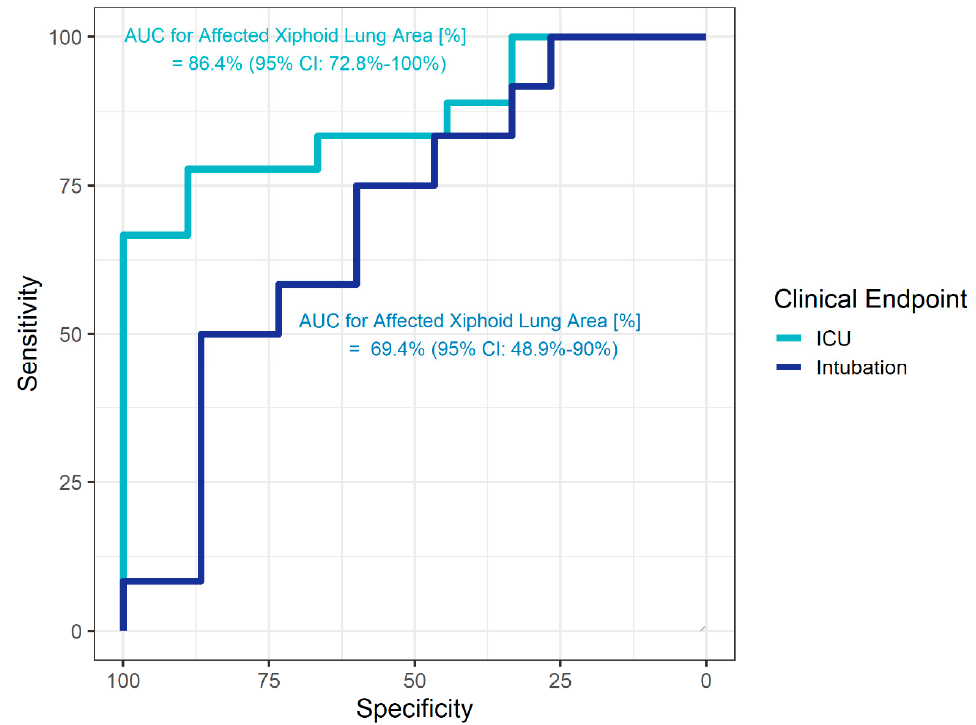
Figure A2. Diagnostic performance for prediction of intensive care unit (ICU, dark blue) treatment or intubation (light blue) in patients with COVID-19. Receiver-operating characteristic (ROC) curves based on the affected lung area on the level of the xiphoid (%).